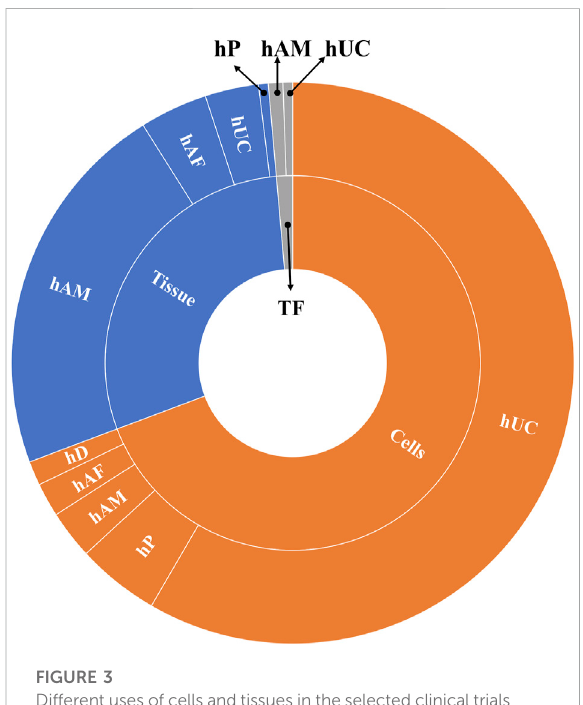
FIGURE 3 Different uses of cells and tissues in the selected clinical trials analyzed. Abbreviations: hP: human placenta; hUC: human umbilical cord; hAM: human amniotic membrane; hAF: human amniotic fl uid; hD: human decidua; TF: trophic factors; hACM: amnio-chorionic